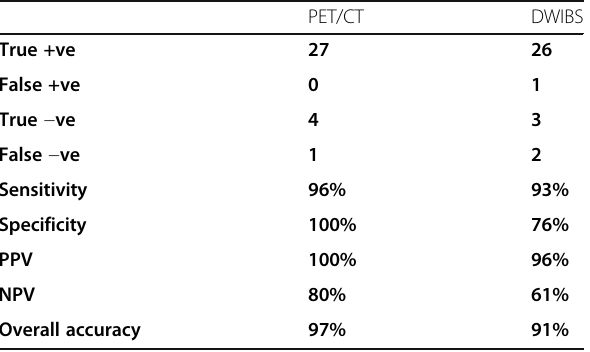
Table 3 Overall comparison between18F-FDG-PET/CT and WB- MR/DWIBS in detection of infiltrated sites in 32 lymphoma patients PET/CT DWIBS